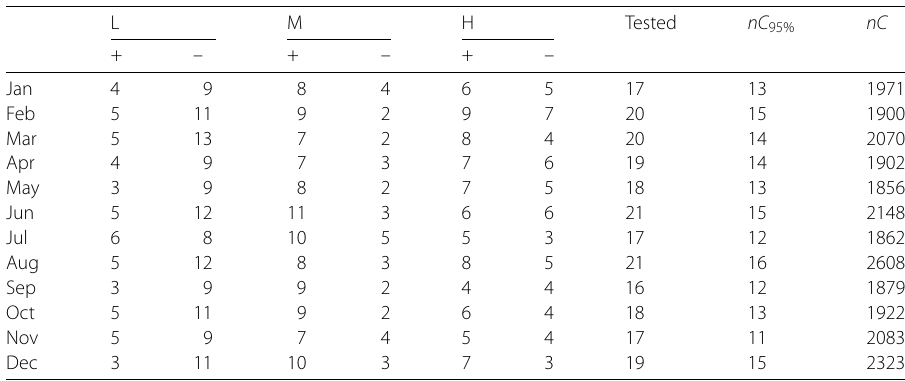
Table 14 Summary for test results: